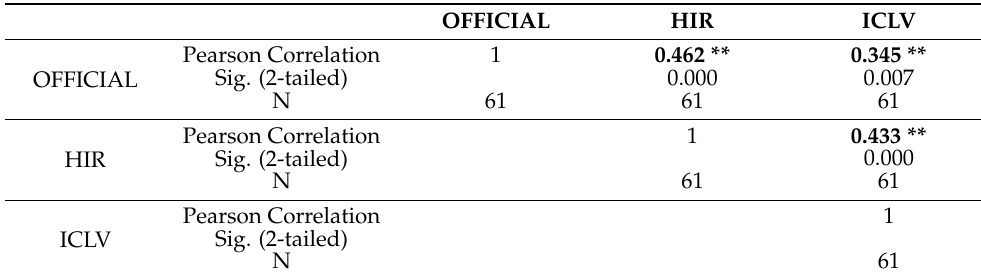
Table 6. Correlations between human classifications and lCLV values for data set 1. HIR means “hired”; Sig. means “significance”; N means “number of texts”.